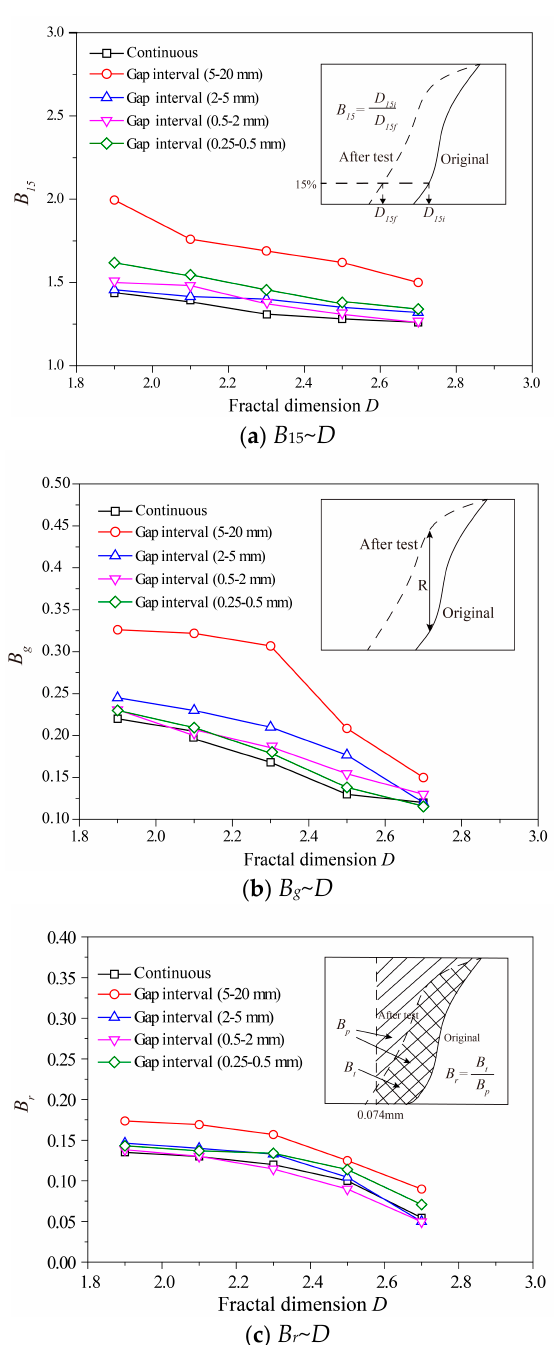
Figure 7. Particle breakage of SRMs with fractal dimension D at different gap intervals.